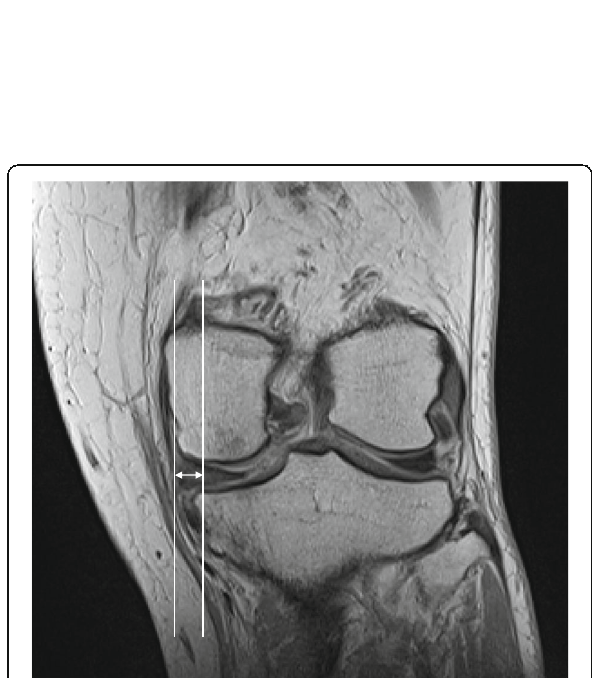
Fig. 6 Measurement of two-dimensional (2D) medial meniscal extrusion (MME) width. 2D MME width is defined as the distance from the most extruded edge of the medial meniscus to the edge of the medial tibial plateau. The reference point for 2D MME width is the tibial plateau without the osteophyte. A vertical line is drawn connecting the femur and the reference